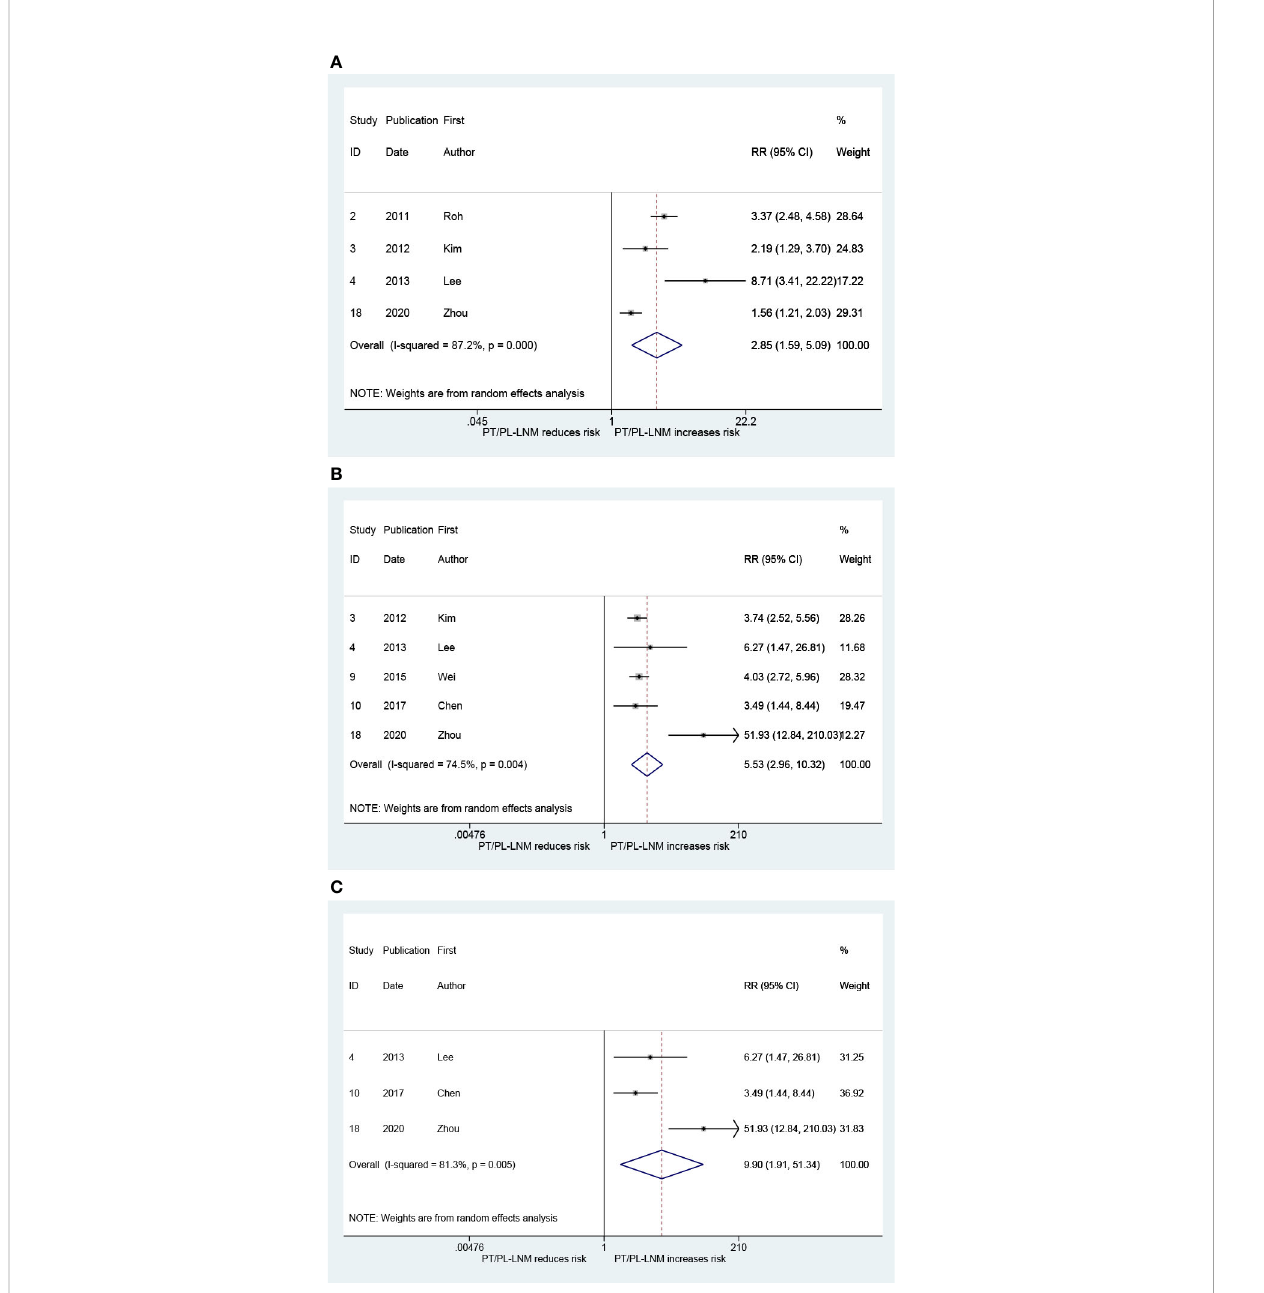
FIGURE 6 The relative risk for other groups ’ lymph node metastasis in patients with pretracheal and/or prelaryngeal lymph node metastasis (PT/PL-LNM). (A) Ipsilateral paratracheal lymph node metastasis. (B) Contralateral paratracheal lymph node metastasis. (C) Contralateral paratracheal lymph node metastasis in the subgroup of patients without lateral lymph node